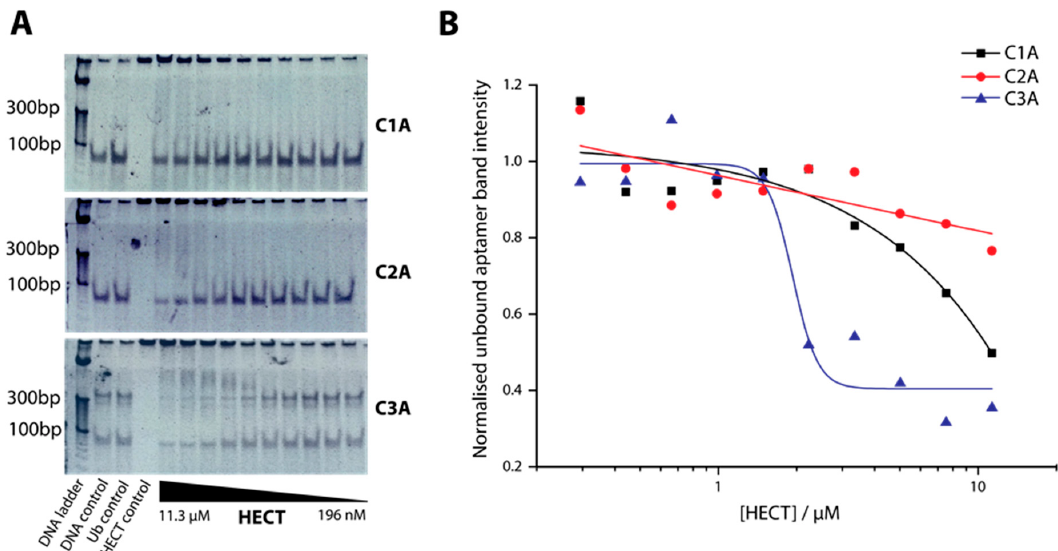
Figure 3. Determination of K D for aptamers using electrophoretic mobility shift assay (EMSA) for aptamers C1A, C2A, and C3A. ( A ) 10% PAGE gels showing bound (upper bands) versus unbound (lower bands) aptamer; ( B ) Plot of HECT concentration versus normalized band intensity (unbound) with a one-site binding fit from representative data in Figure 3A.